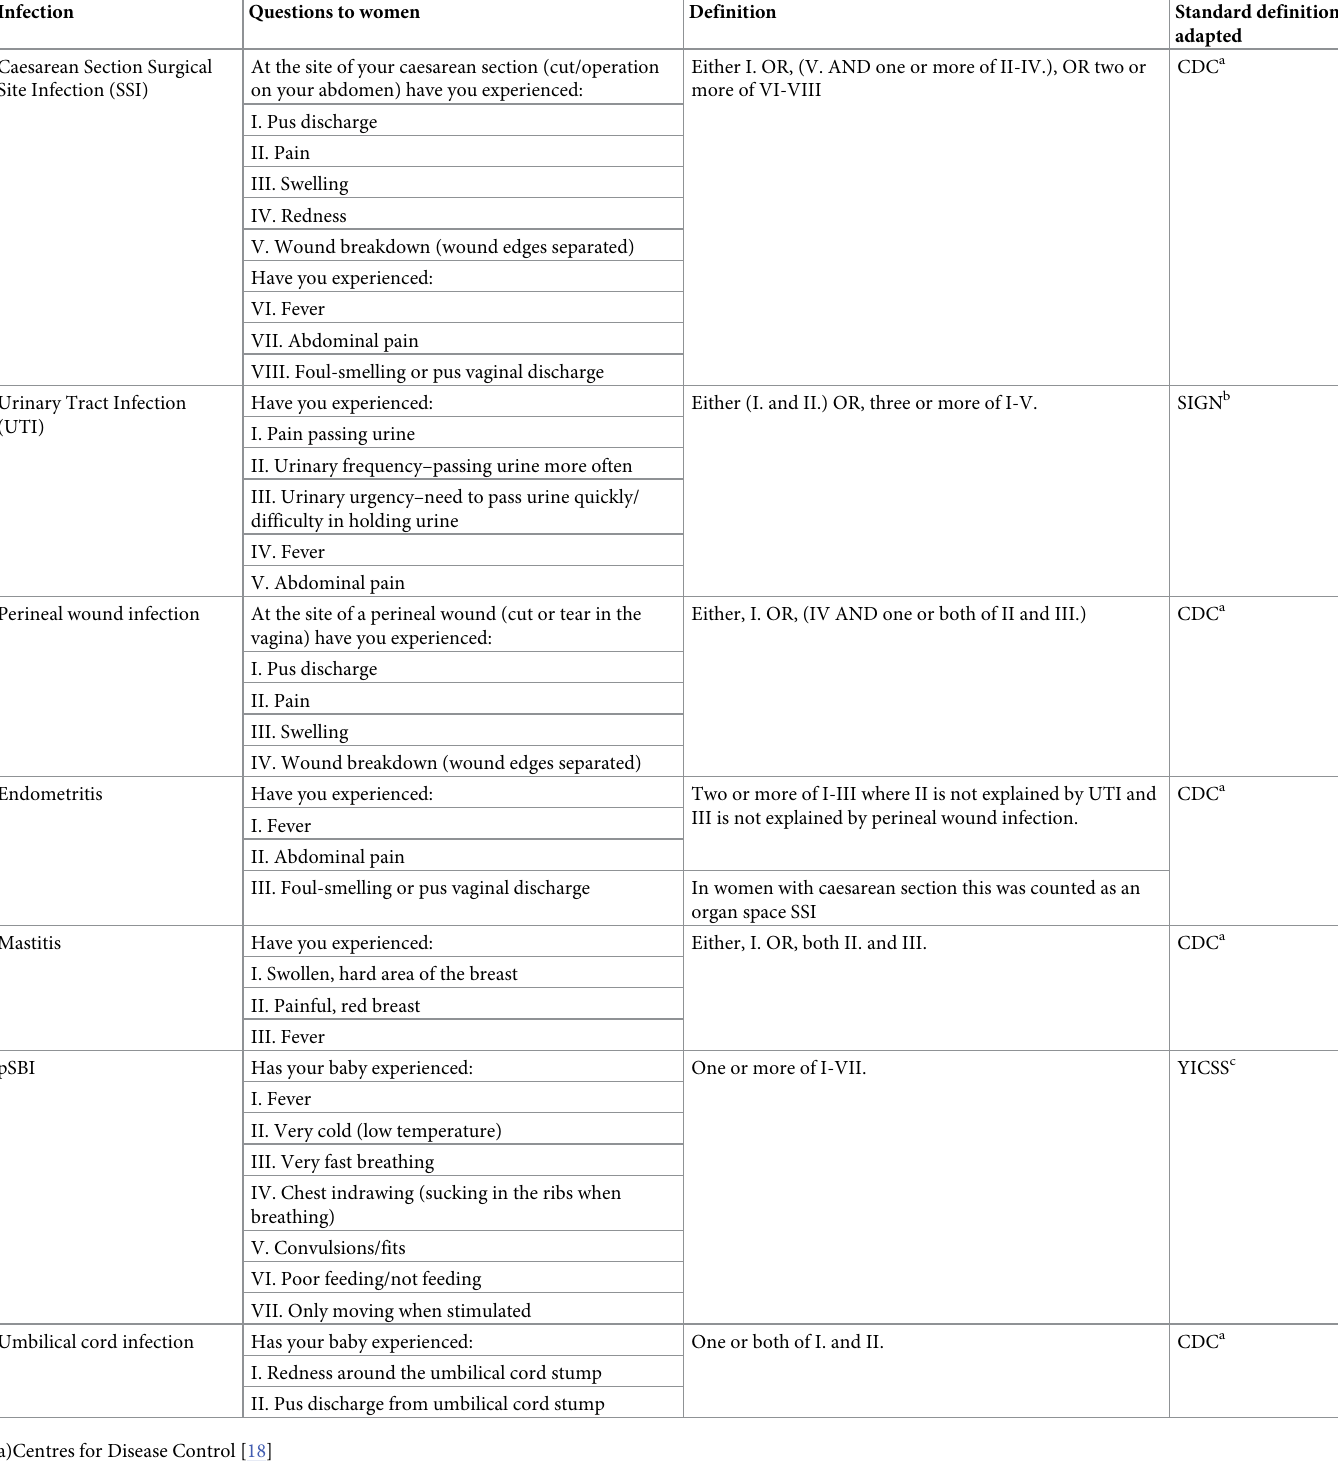
Table 1. Syndromic infection definitions